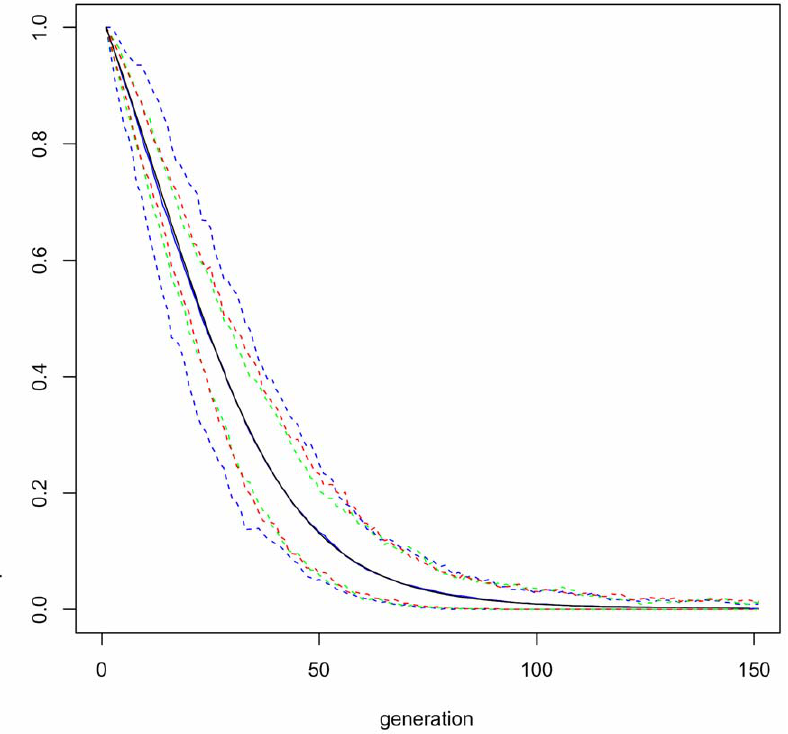
Figure 3. Drift effects under survival selection. Drift effects are studied in populations undergoing survival selection (Option a. in the main matter), using prevalence of the deleterious mutation in Y chromosomes as a summary statistic. The black line represents the theoretical value of this statistic, calculated by applying Equation 3 iteratively. The colored lines illustrate the distribution of this statistic in small populations ( n 0 ~ 200 blue, n 0 ~ 1,000 green, and n 0 ~ 5,000 red). The dashed lines indicate the 0.05 and 0.95 quantiles of these distributions. The solid blue line indicates the sample mean for n 0 ~ 200 . (For n 0 ~ 1,000 and n 0 ~ 5,000 , the sample mean has been omitted, because it is so near to the expectation.) For each n 0 , 150 Monte Carlo replicates have been generated. The rate of sex reversal is r ~ 0 : 1 , and the other parameter values are as in ‘Baseline’, Table 1.